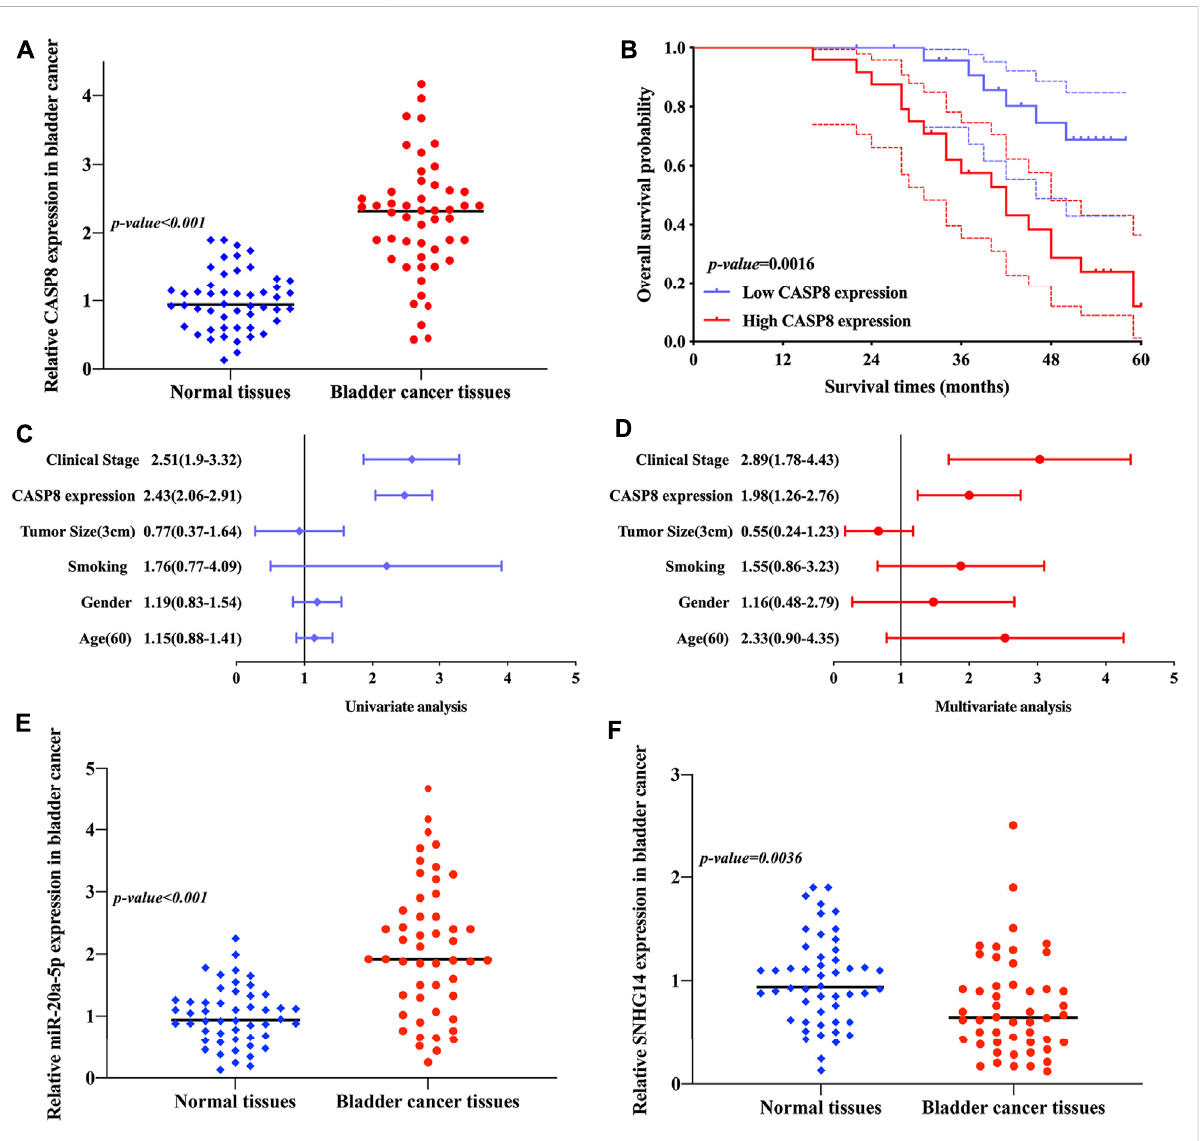
FIGURE 11 Validation of the expression of SNHG14/miR-20a-5p/CASP8 and the overall survival of CASP8 in bladder cancer. (A) CASP8 expression was upregulated in bladder cancer versus bladder tissues. (B) Bladder cancer patients with high CASP8 expression had a poor overall survival. (C,D) Univariate and multivariate analyses demonstrated the CASP8 expression and clinical stage as prognostic factors affecting the overall survival of bladder cancer patients. (E,F) Upregulation of miR-20a-5p and downregulation of lncRNA SNHG14 were obtained in bladder cancer versus bladder